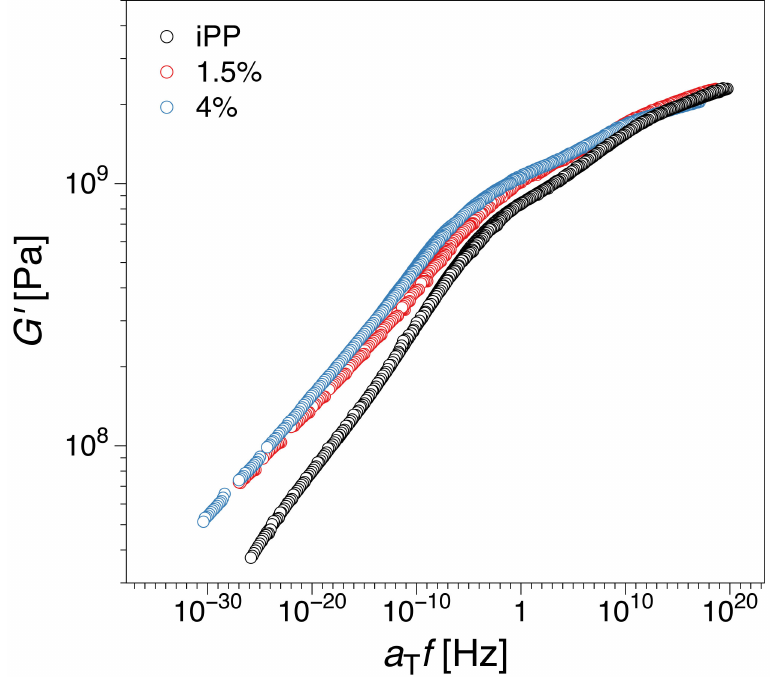
Figure 4. Mastercurve of shear storage modulus, G (cid:48) , obtained by horizontal shifting in frequency for iPP and compositions with 1.5 and 4 wt.% filler content respectively. Temperature range: − 50 to 150 ◦ C (223.15 to 423.15